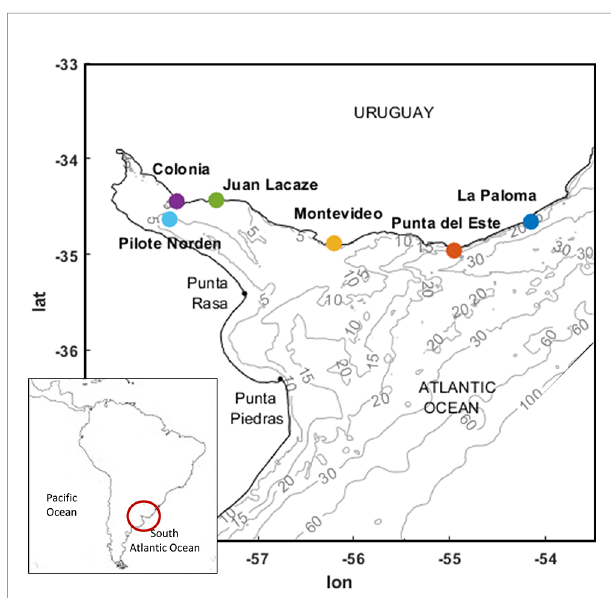
FIGURE 1 | Study area and in-situ measurements stations along with the bathymetry of the